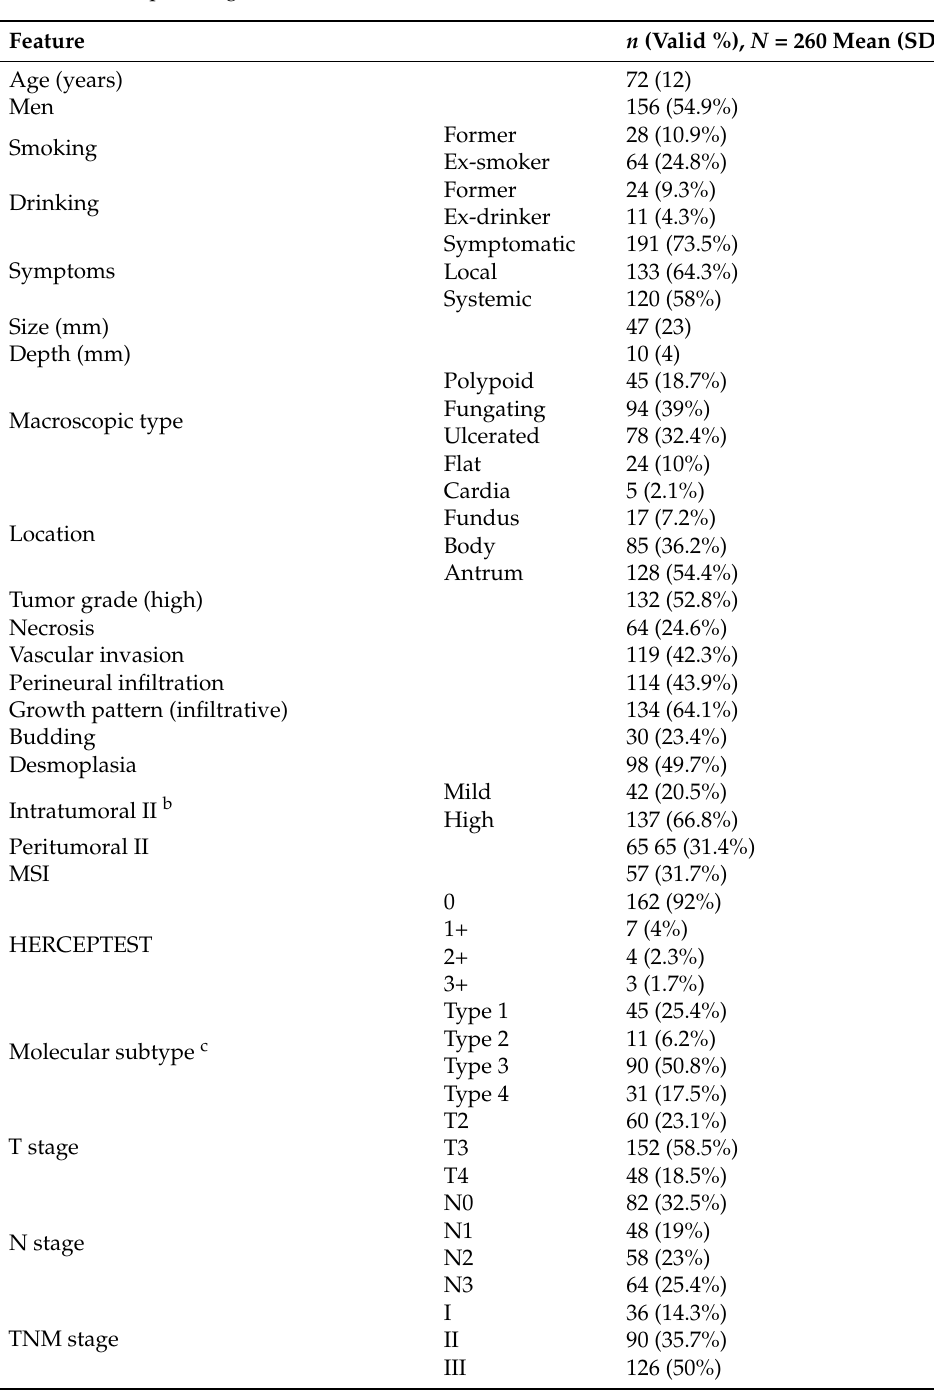
Table 1. Clinicopathological features of our